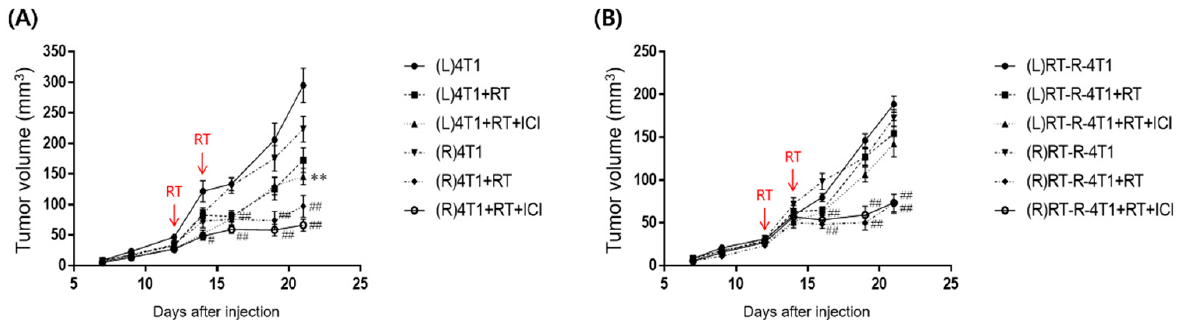
Figure 1. Combined PD- 1 blockade therapy and RT enhanced antitumor abscopal effects. Six-week- old female balb/c nude mice were injected with 5 × 104 of 4T1 ( A ) or RT-R-4T1 ( B ) cells into the right flank (R, primary; irradiated) and left flank (L, secondary; non-irradiated) (n = 4~6). From day 7 after inoculation, tumor volumes were measured 3 times a week until day 21. Arrows indicate the points at which RT was delivered. ** p < 0.01 compared to the secondary (L) tumor of non-treated 4T1 or RT-R-4T1-injected group; # p < 0.05, ## p < 0.01 compared to the primary (R) tumor of non-treated 4T1 or RT-R-4T1-injected group.